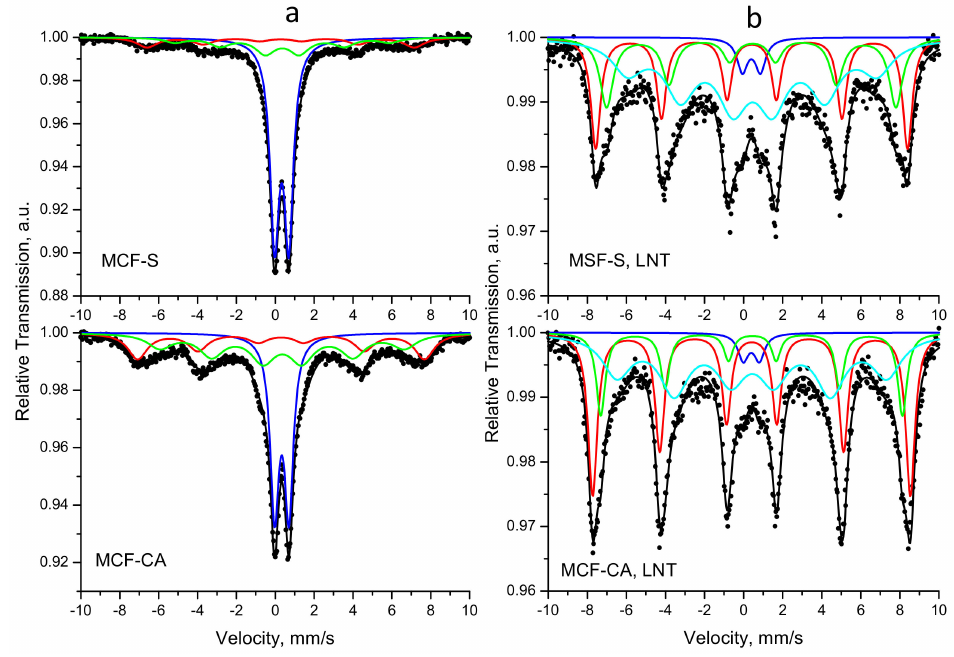
Figure 5. Mössbauer spectra of MCF-S and MCF-CA at 25 ◦ C ( a ) and at − 196 ◦ C ( b ). A model containing two sextets and one doublet was used for the mathematical pro- cessing of the spectra. Sextet parameters corresponding to Fe 3+ in a tetrahedral coordination (with lower isomer shift) and Fe 3+ in an octahedral coordination (with higher isomer shift) in a spinel-type structure were obtained. The doublet components are probably due to small ferrite moieties that exhibit superparamagnetic properties. The relative weight of the doublet (Table 2) in MCF-S (G = 65%) is higher than that of the doublet in MCF-CA (G = 37%); hence, MCF-S is more finely crystalline than MCF-CA. These results are in full agreement with those obtained by XRD, SEM, and nitrogen adsorption